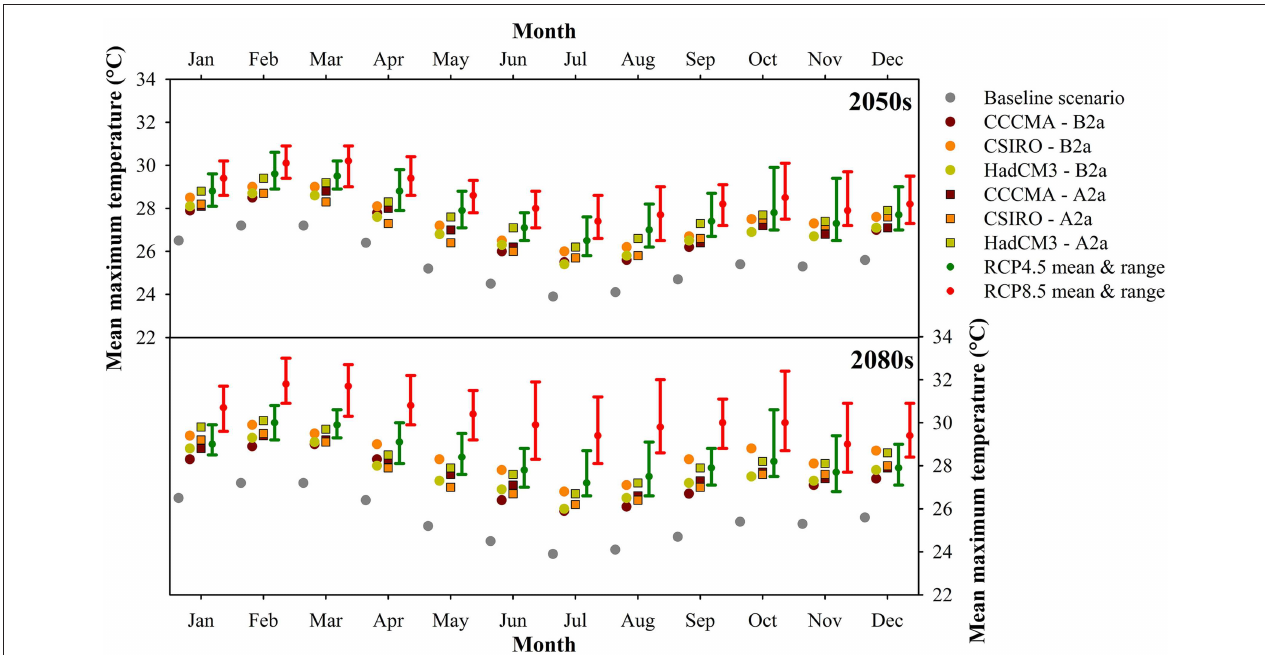
FIGURE 2 | Mean daily maximum temperature for each month at the baseline location, according to different climate datasets: gray dots show current conditions according to the WorldClim database, brown, orange, and yellow circles (B2a emissions) and squares (A2a emissions) indicate projections with the CCCMA CGCM2, CSIRO MK2, and HadCM3 climate models, according to AR4 scenarios used in this study. The green and red dots with error bars show the means and ranges of projections from the AFRICLIM climate model ensemble (Platts et al., 2015), which uses projections from 10 General Circulation Models for the